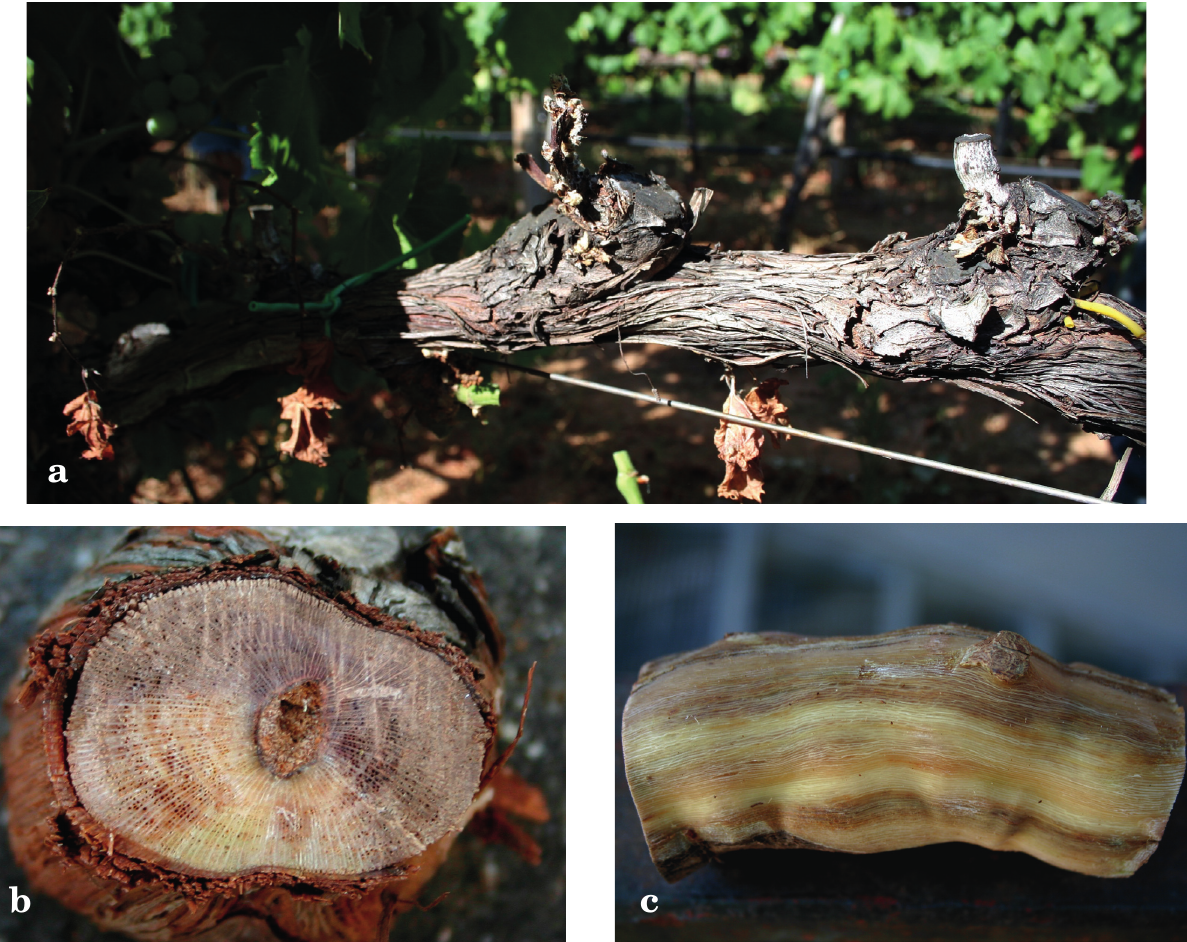
Figure 1. Grapevine disease symptoms associated with Neofusicoccum australe : cordon dieback (a); cordon wedge- shaped necrotic sector (b); trunk brown stripes under the bark